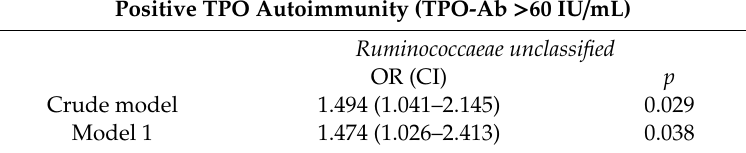
Table 3. Adjusted model for autoimmunity thyroid profile (Positive TPO-Ab > 60 IU / mL)—Gut microbiota